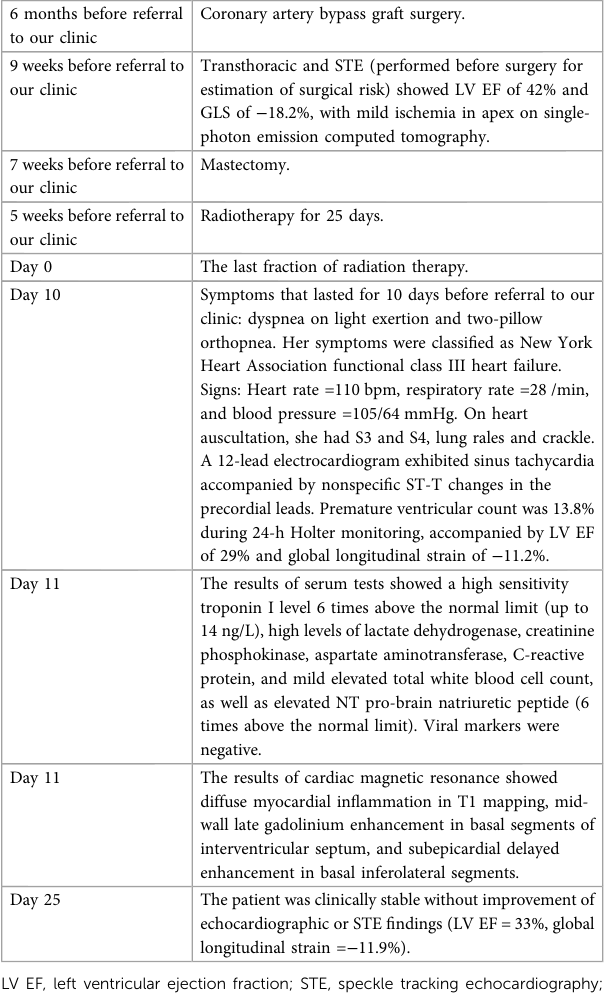
TABLE 1 Timeline of the presenting symptoms, diagnostic, and therapeutic